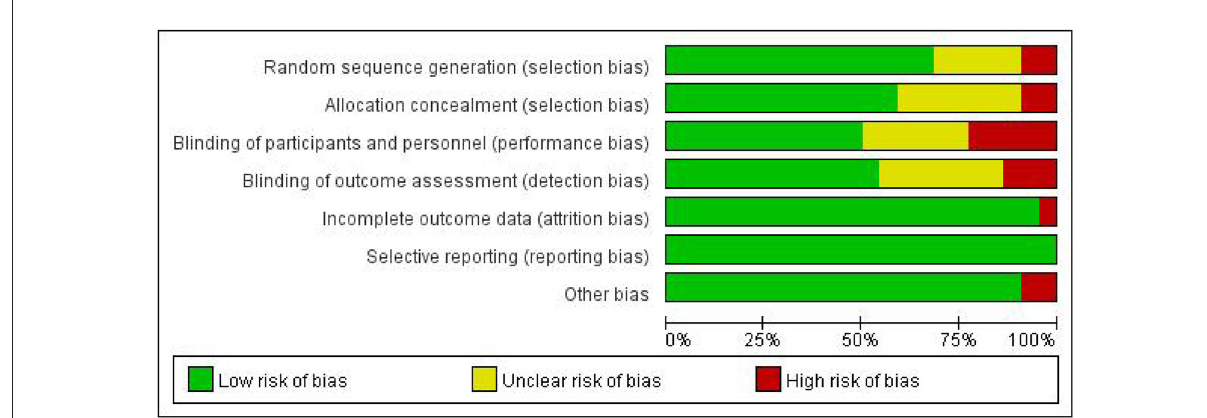
FIGURE2 Risk of bias graph.